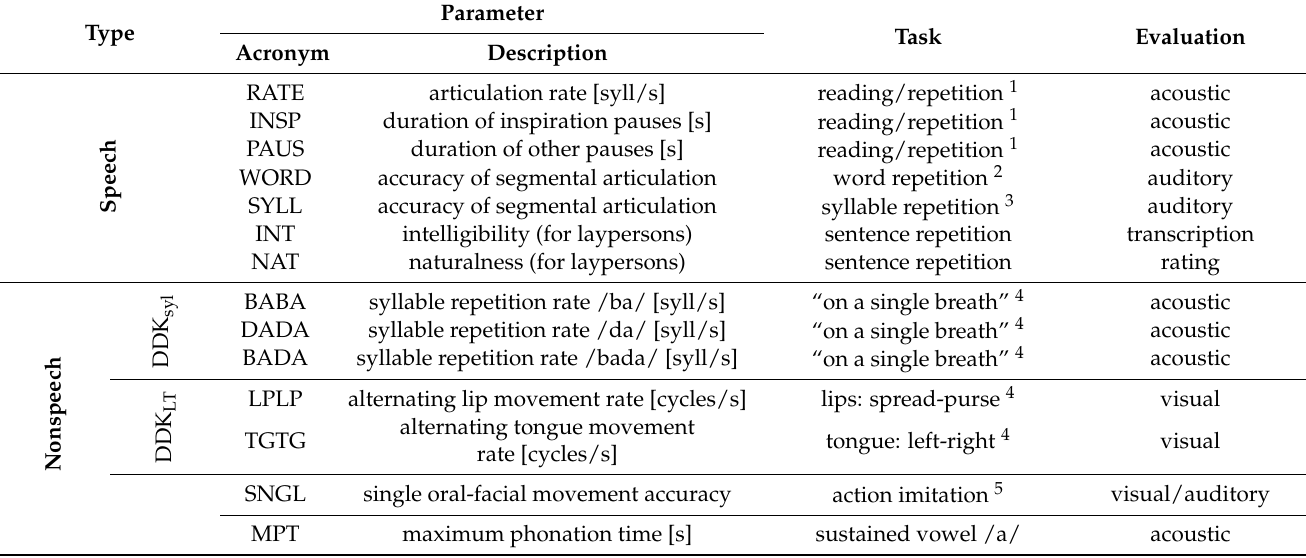
Table 2. Overview of specific diagnostic parameters (for details see